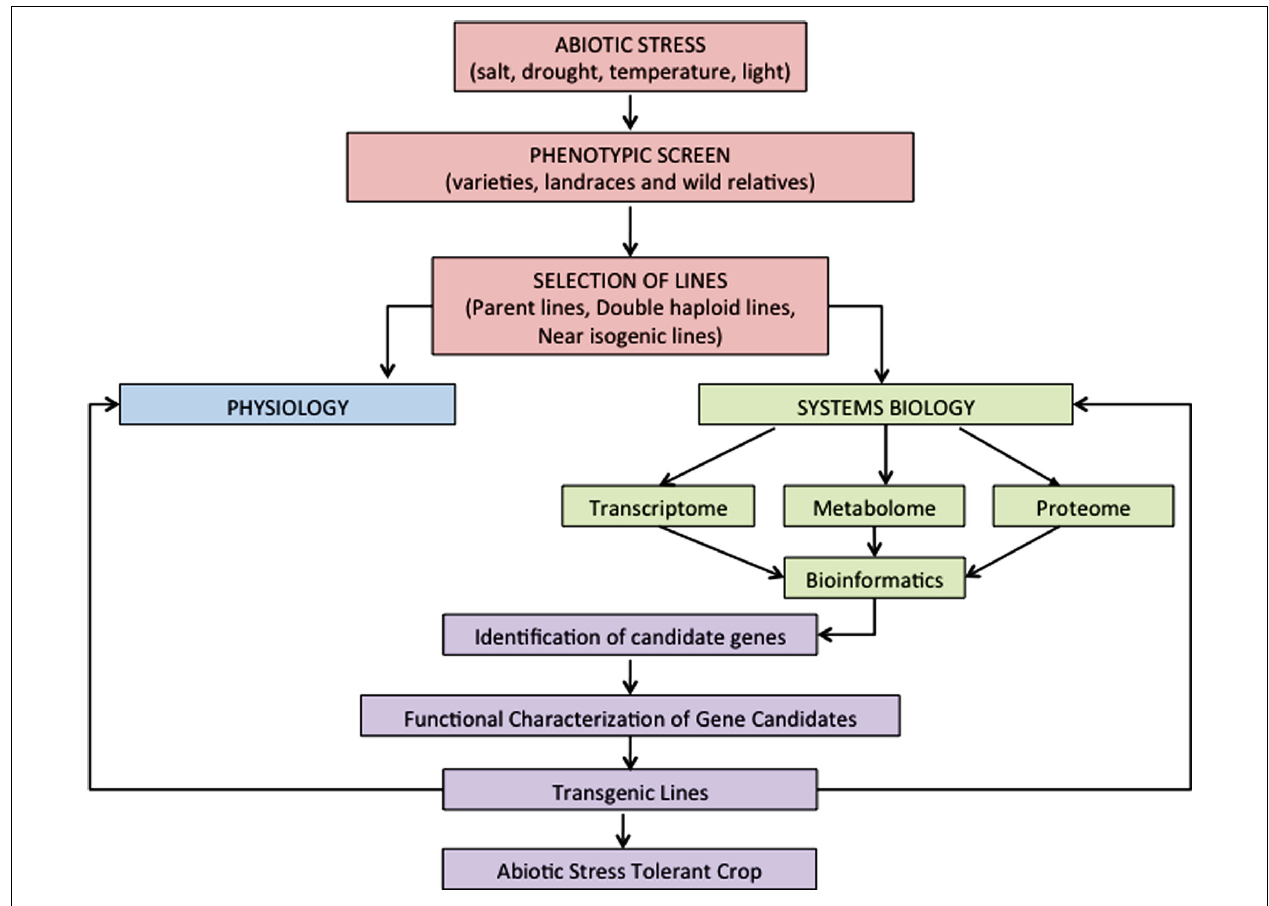
FIGURE 1 | Proposed strategy for the integration of physiology and systems biology to gain insights into abiotic stress responses in cereals and the future development of abiotic stress tolerant